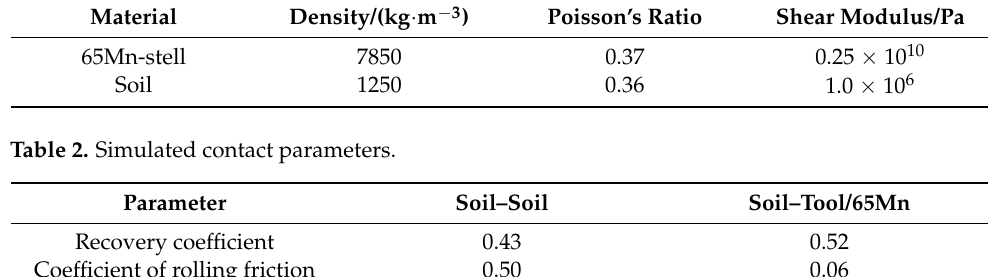
Table 1. Material intrinsic parameter.